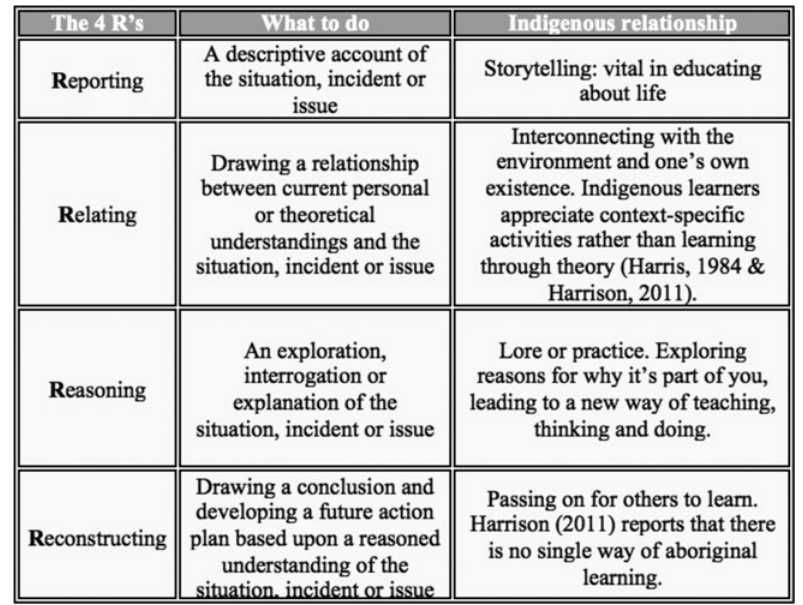
Figure 2. 4Rs model for reflective practice.